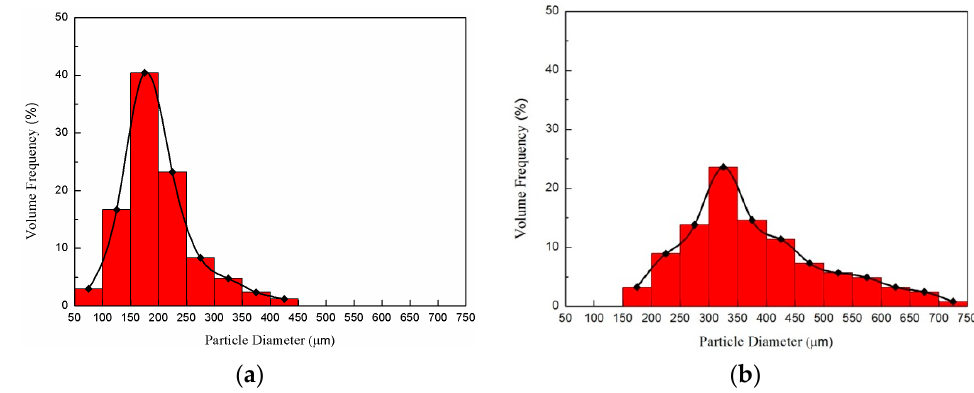
Figure 8. Dependence of atomized liquid droplet distribution on degree of flash boiling at ( a ) 65/40 and ( b ) 85/60 bar.